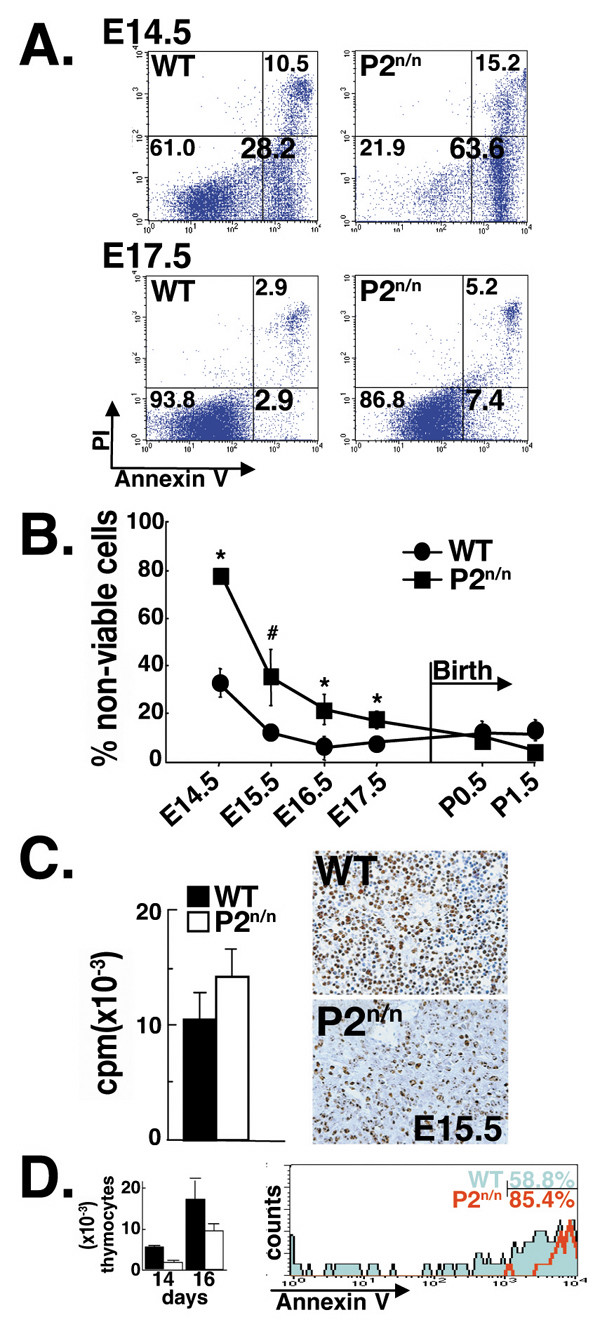
P2neo/neo thymocytes display enhanced apoptosis, but have normal cell proliferation capacity. (A) FACS analysis of E14.5 and E17.5 WT (left panels) and P2neo/neo (right panels) thymocytes stained with Annexin V and PI. FACS dot plots and percentages of cells in each quadrant are indicated. Note the >2 fold increase in the proportion of apoptotic cells (Annexin V+/PI-) and of necrotic cells (Annexin V+/PI+) in P2neo/neo thymi. (B) P2neo/neo thymocytes display enhanced apoptosis throughout embryonic thymopoiesis. Proportion of non-viable (apoptotic+necrotic) WT and P2neo/neo cells gradually decreased during embryonic development. Nevertheless, at any given time point, P2neo/neo thymui contained a higher proportion of non-viable cells compared to WT littermates. After birth the proportion of non-viable thymocytes in P2neo/neo became similar to WT. At least five mice of each genotype were analyzed. The differences between WT and P2neo/neo apoptotic thymocytes were significant at P < 0.001 (*) and P < 0.01 (#) by Student's t test. (C) P2neo/neo thymocytes retain normal proliferation capacity. Following FACS analysis an equal number (1 × 104) of E15.5 WT or P2neo/neo Annexin V negative thymocytes were incubated with TPA (20 ng/ml) and ConA (5 μg/ml) for 48 h. 3H-thymidine was present during the last 18 h of incubation. Differences between WT and P2neo/neo were statistically insignificant by Student's t test. Proliferation capability of thymocytes was further examined by immunostaining of E15.5 thymic lobes for the proliferation-associated antigen recognized by Ki-67 antibodies (Right panels). (D) Enhanced embryonal apoptosis is a cell-autonomous property of P2neo/neo thymocytes. WT or P2neo/neo E15.5 FL HPC were differentiated under saturating conditions in E14.5 WT FTOC for 14 or 16 days. We predetermined that ~100 FL cells (either WT or P2neo/neo) per lobe were sufficient to populate all available thymic lobes and therefore used 1000 FL cells per lobe. Thymocytes accumulation in FTOC populated with P2neo/neo FL HPC is reduced compared to WT (left panel WT-black; P2neo/neo-white). Proportion of apoptotic thymocytes (Annexin V+) derived from FTOC populated with P2neo/neo FL cells (red) was considerably higher compared to WT (light blue) (right panel).